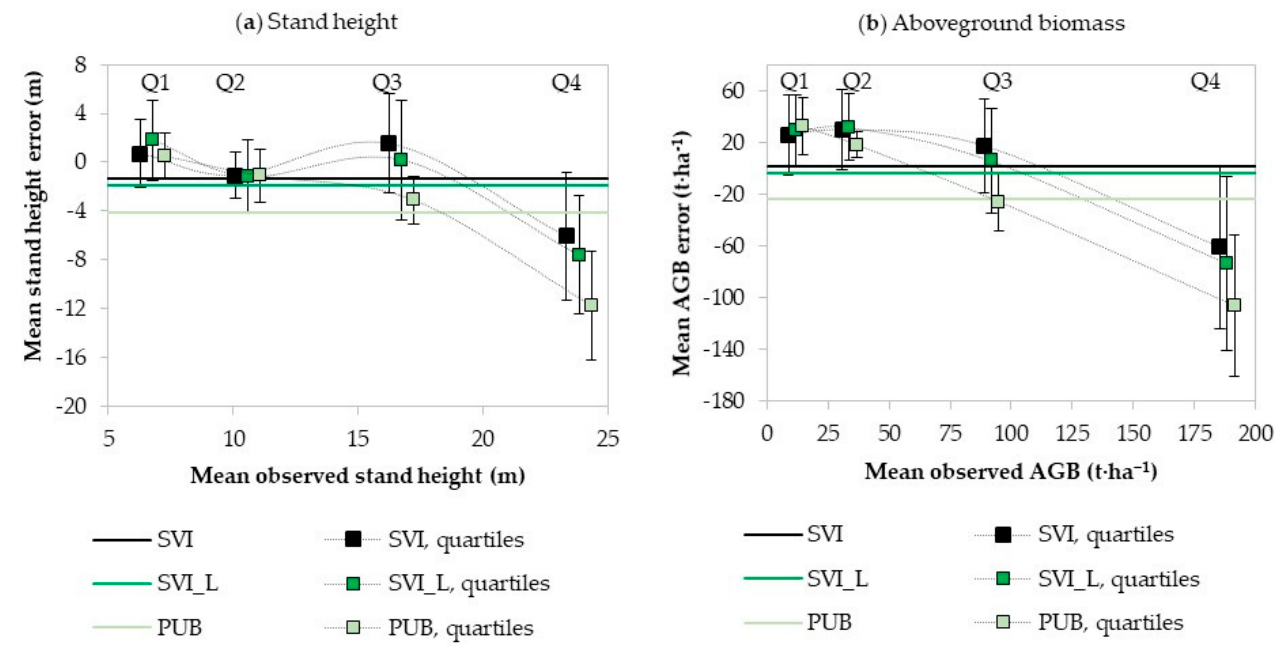
Figure 11. Plot of mean prediction error (predicted minus observed) for ( a ) stand height and ( b ) AGB using all NFI plots (horizontal lines) and NFI plots grouped by quartiles Q1 to Q4 (mean error ± one standard deviation, dots) for SVI maps, Landsat-based SVI_L maps and published (PUB) maps. Dotted lines are added to highlight trends across four quartiles.